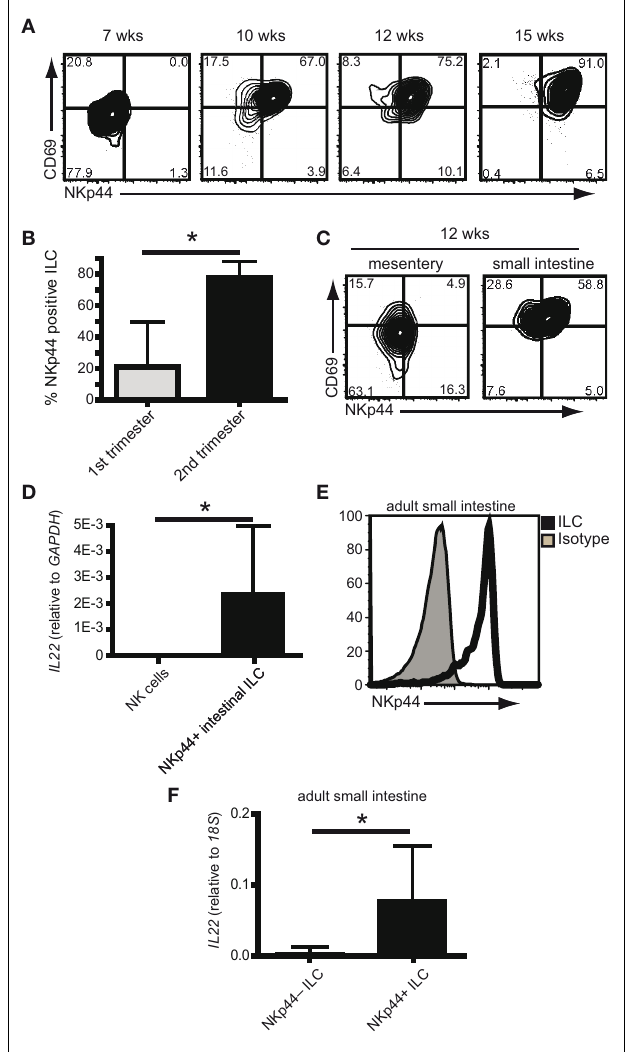
FIGURE 4 | Human NKp44 + ILC are developmentally programmed. (A) Flow cytometric analysis of ILC from fetal intestines of indicated ages (weeks gestation) (representative examples of at least three independent experiments per time point). (B) percentage of ILC expressing NKp44 in the fetal small intestine during first trimester ( < 12weeks) or second trimester ( > 12weeks) ( n > 6; average ± SD; p = 0.003). (C) Flow cytometric analysis of ILC in fetal small intestines and mesentery of the same donor at 12weeks gestation (representative example of three independent experiments). (D) Expression of IL22 transcripts in NKp44 + ILC from fetal intestine compared to NK cells from fetal lymph node (five independent samples per condition, average ± SD; p = 0.009). (E) Flow cytometric analysis of NKp44 expression on ILC from adult intestine. Filled histogram shows isotype control staining (representative example of five independent experiments). (F) Expression of IL22 transcripts in NKp44 + and NKp44 − ILC from adult intestine ( n = 7, average ± SD; p =